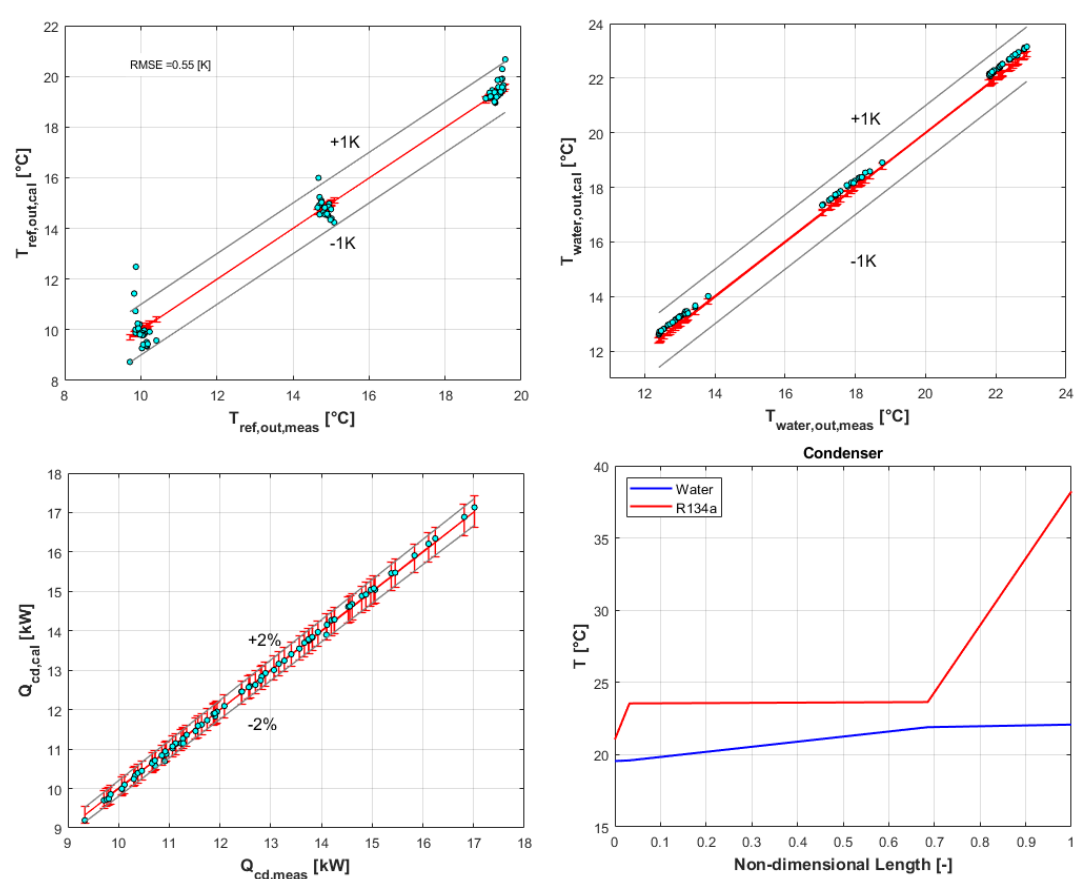
Figure 19. Results of the condenser hydrothermal model vs. experimental data: refrigerant discharge temperature ( top-left ), water discharge temperature ( top-right ), thermal load in the refrigerant side ( bottom-left ), and temperature profile for one of the experimental points ( bottom-right